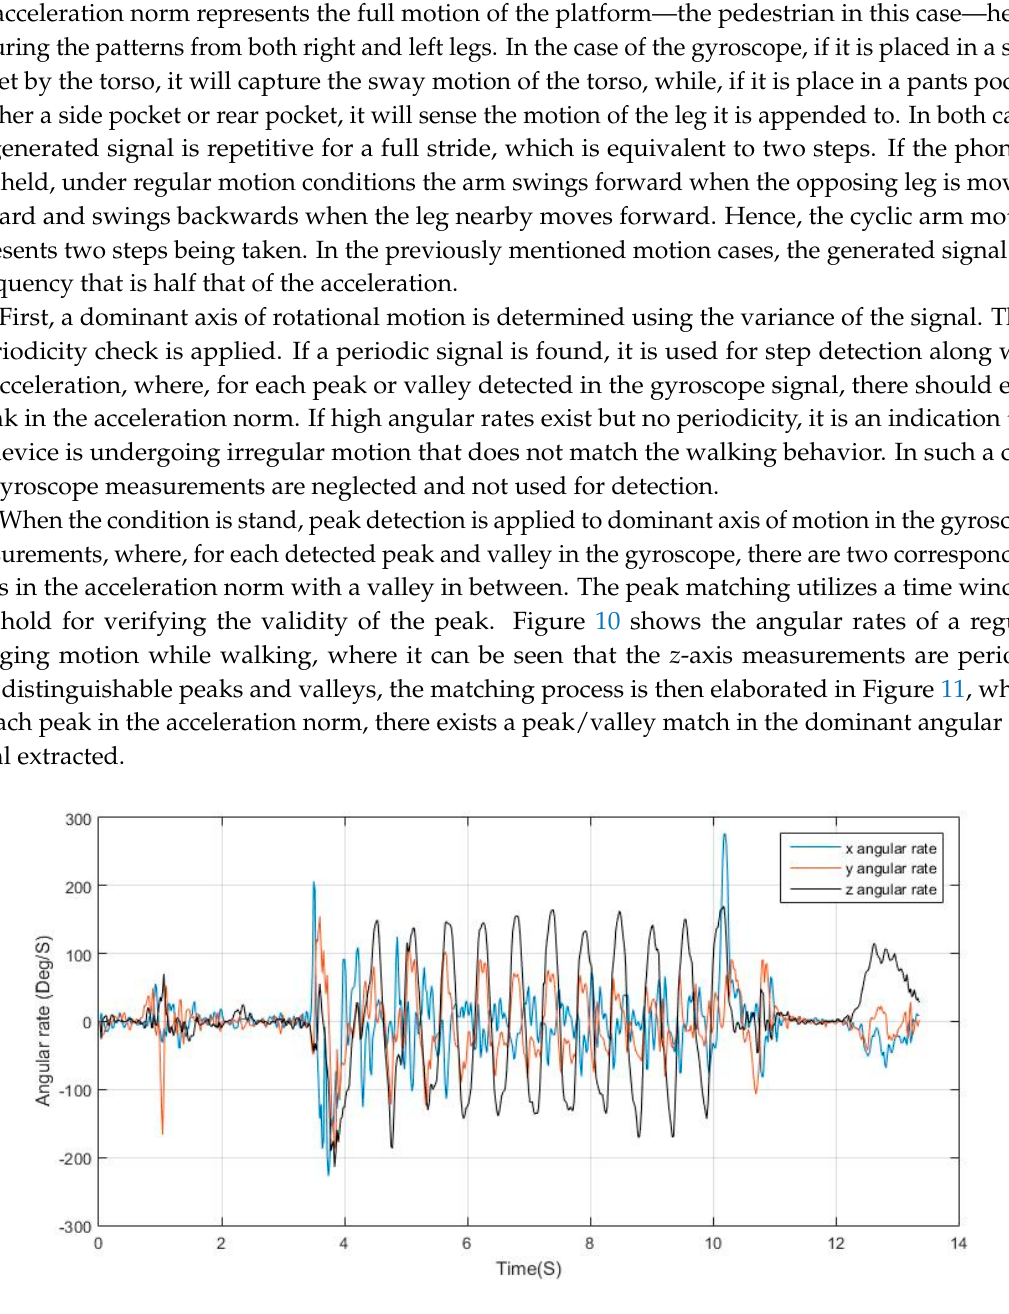
Figure 10. Gyroscope measurements for phone dangling case.